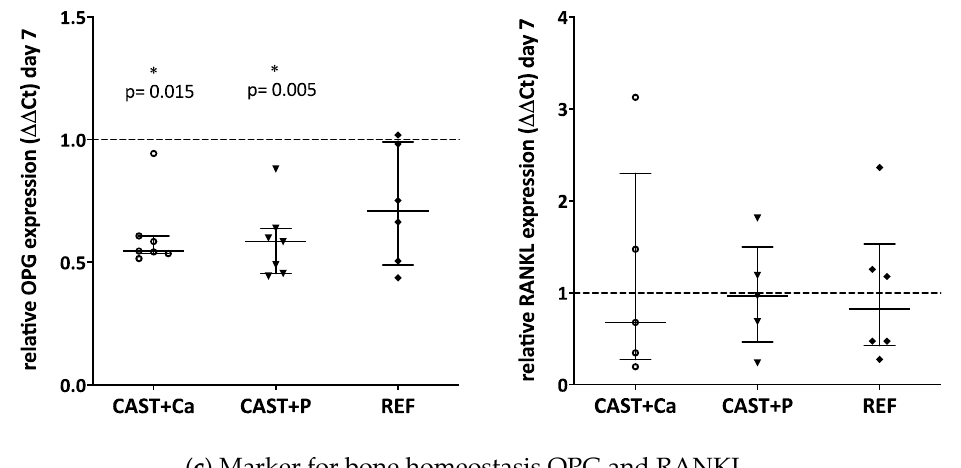
( c ) Marker for bone homeostasis OPG and RANKL.